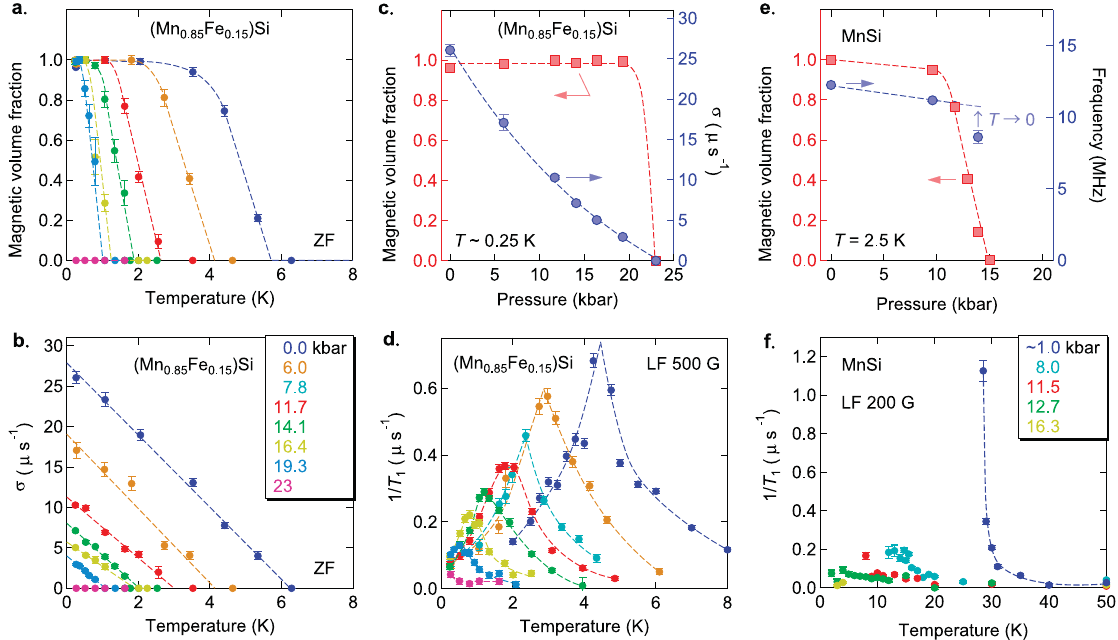
Fig. 3 Static local fi eld, ordered volume fraction and dynamic relaxation rate in (Mn,Fe)Si and MnSi. a – d : MuSR results for (Mn 0.85 Fe 0.15 )Si in ZF ( a – c ) and in LF = 500 G ( d ). a Temperature and pressure dependence of the magnetically ordered volume fraction determined by ZF-MuSR. b Static muon spin relaxation rate σ , which is proportional to the ordered moment size. c Pressure dependence of the magnetic volume fraction and the static spin relaxation rate at T ~ 250 mK (lowest temperature achievable by the 3 He cryostat), demonstrating the continuous evolution of the order parameter σ from zero in the paramagnetic phase to fi nite values in the ordered phase, and the development of static magnetic order in the full volume fraction in the ordered phase at low temperatures. d Dynamic relaxation rate 1/ T 1 observed in LF = 500 G. The sharp peak of 1/ T 1 is a signature of dynamic critical behavior expected for a second-order thermal phase transition. e , f Results of a previous MuSR study 13 in pure MnSi, replotted here to be contrasted to those of (Mn,Fe)Si. Panel e demonstrates that the ordered moment size, proportional to the ZF MuSR frequency, changes discontinuously at the phase boundary, while the magnetic volume fraction changes continuously. Panel f demonstrates that the dynamic critical behavior is suppressed with increasing pressure and completely eliminated at p = 12.7 kbar for MnSi. This behavior in MnSi is characteristic of fi rst-order quantum